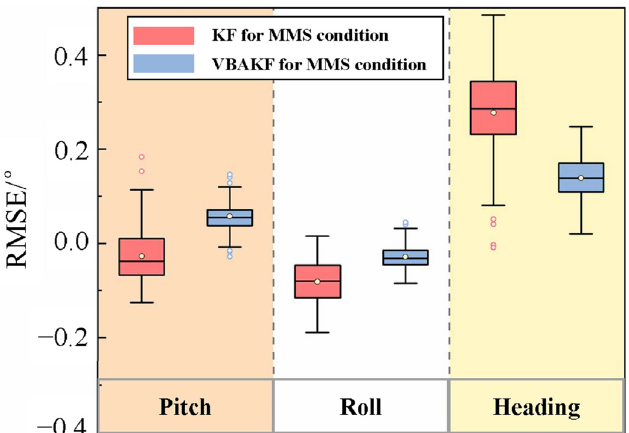
Figure 9. Filter error box plot of interference evaluation and multi-mode switching algorithm. Table 5. The RMSE result of the three-dimensional attitude estimation errors of the interference evaluation and multi-mode switching